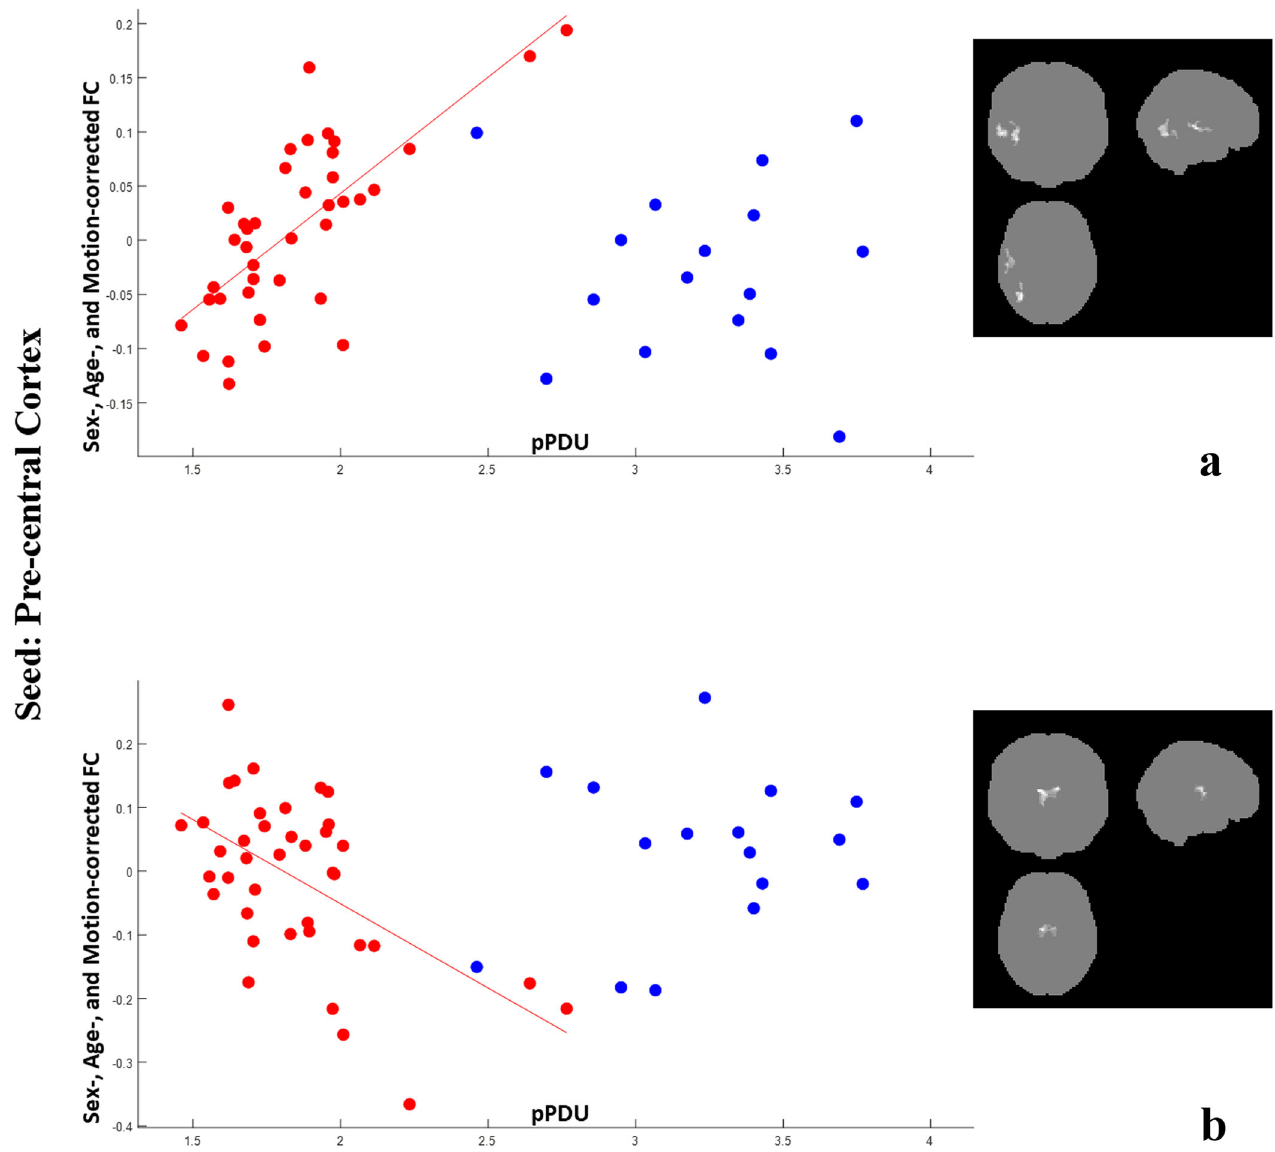
Fig. 3 Correlations of pre-central cortex FC with pPDU. Scatterplots for PD (red) and ET (blue) patients of the mean FC of the clusters (highlighted in the inserts on the right, the most affected side is at reader ’ s left) showing a signi fi cant correlation of the pre-central cortex FC ( y axis) with pPDU ( x axis) in PD patients. For the purposes of the graph, for each contrast all clusters were averaged as they provided substantially overlapping patterns of correlation. The FC of the pre-central cortex on the MAS with the homolateral superior/mid temporal gyri and inferior occipital cortex shows a signi fi cant direct correlation with pPDU in PD patients, with no signi fi cant correlation in ET patients in the same regions ( a ). On the contrary, The FC of the pre-central cortex on the MAS with the thalami decreased with increasing pPDU in PD patients ( b